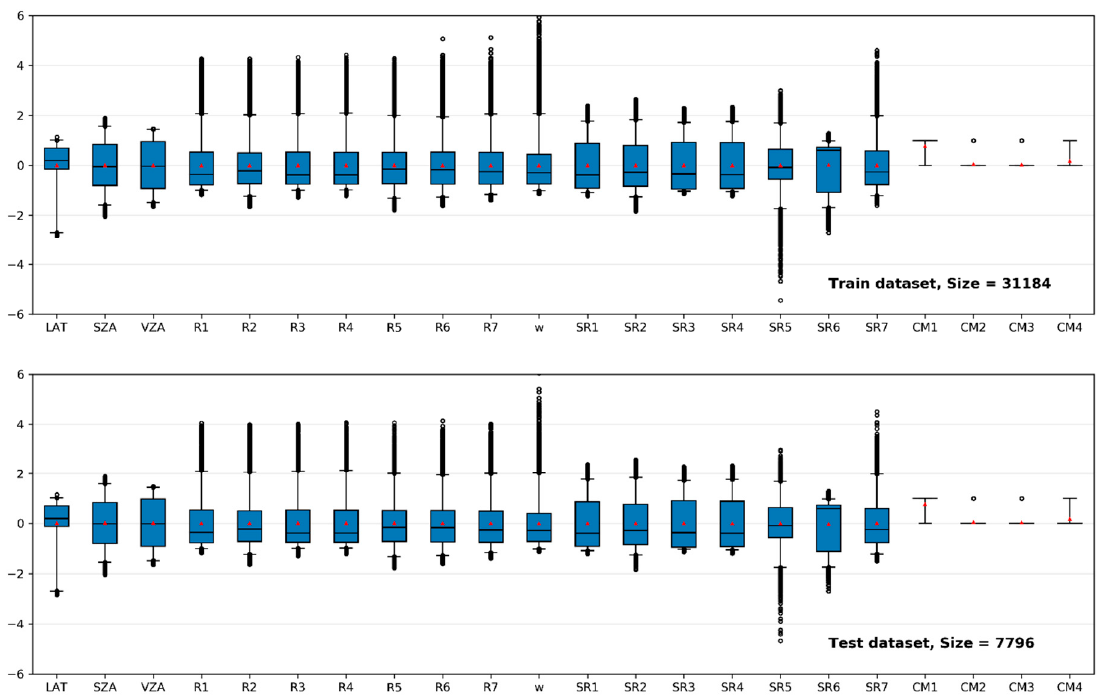
Figure 3. Boxplot of normalized independent variables of the train dataset and test dataset.